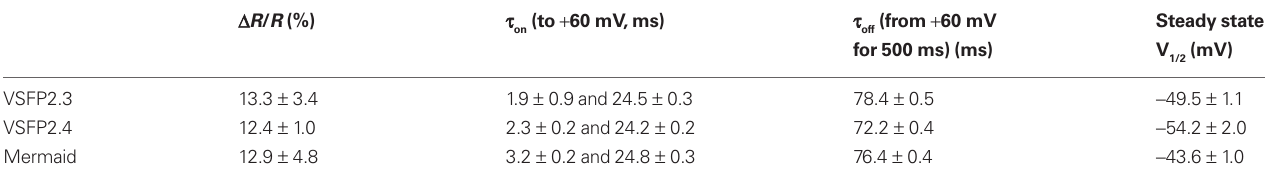
Table 1 | Fluorescence response properties of VSFP2.1 variants. Steady state spectrally-resolved maximal changes in fl uorescence acquired from voltage- clamped PC12 cells. The Δ R / R values represent the average of 14–37 measurements from hyperpolarized ( − 100 mV) to depolarized ( + 40 mV) membrane potential from fi ve representative cells (data are from Mutoh et al.,